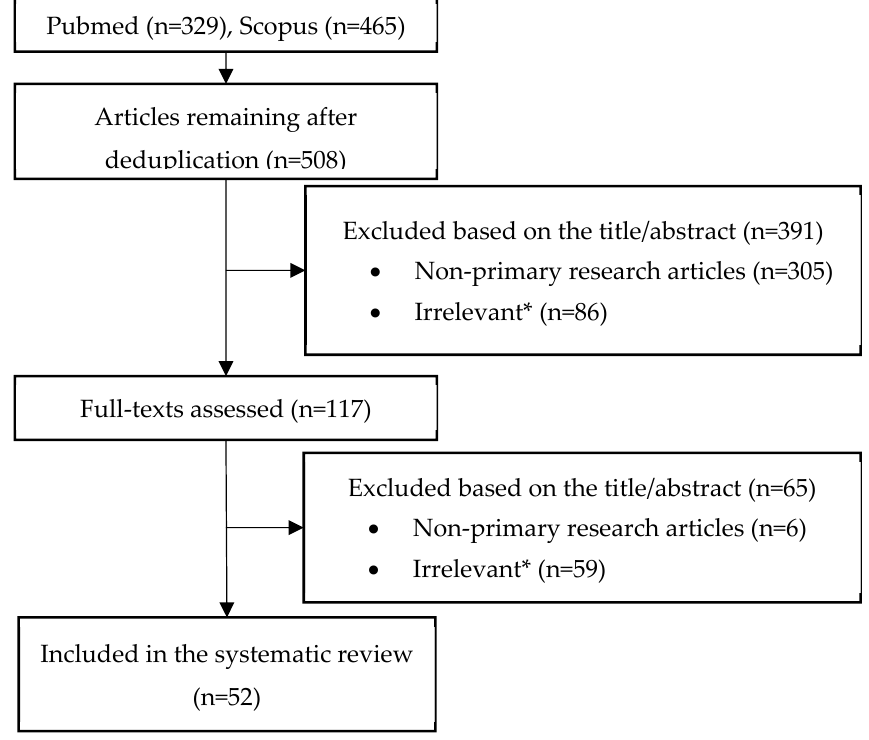
Figure 1. Flow chart. * not satisfying the eligibility criteria described in Methods.